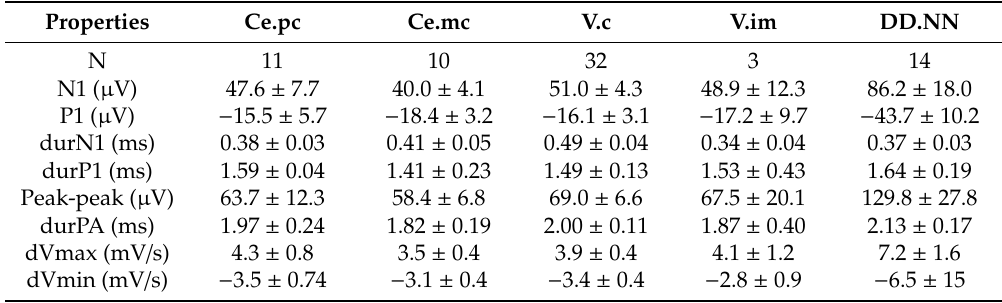
Table A1. Properties of mAP for P1N1. Values as x ± SEM , except of N , which indicates the number of mAP picked up from every nucleus.